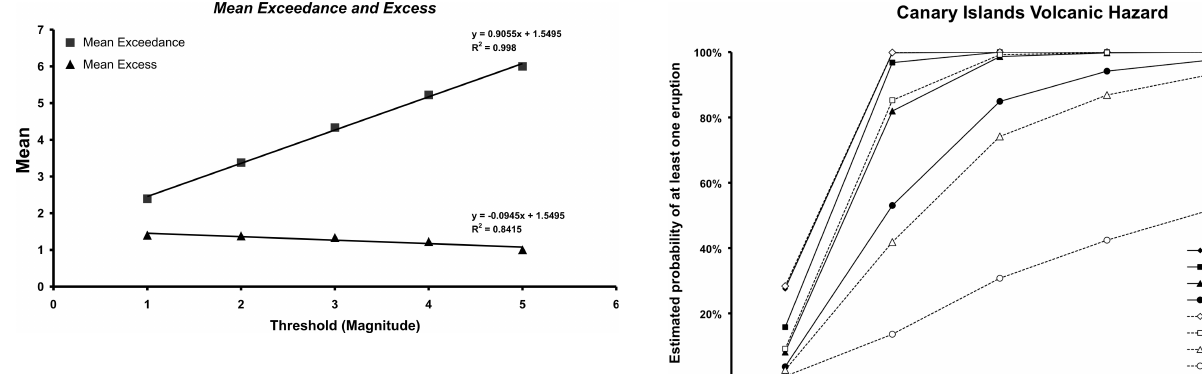
Fig. 5. Plot of exceedance and excess mean vs. threshold for the Canary Islands.